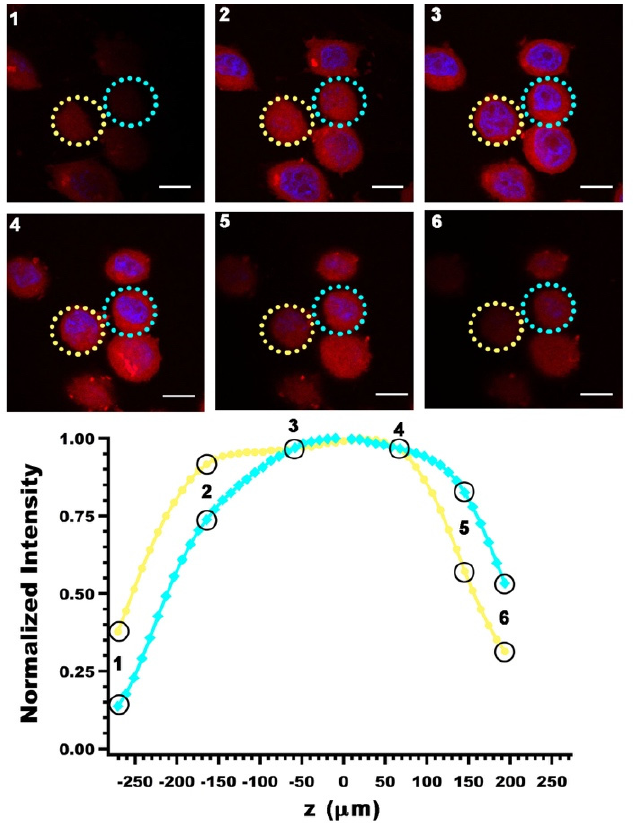
Figure 4. Z-stacks of SKBR3 breast cancer cells images obtained by laser scanning confocal fluorescence microscopy. Images were obtained three hours after incubating the cells with ICG-nEGs at 37 ◦ C, and are falsely colored. Blue channel: DAPI staining of the nucleus; red channel: NIR emission from ICG-nEGs internalized by the cells. Values of normalized fluorescence emission intensity associated with the circled region on each stack are plotted as a function of relative depth of the corresponding stack. Scale bar = 10 µ m in all panels.